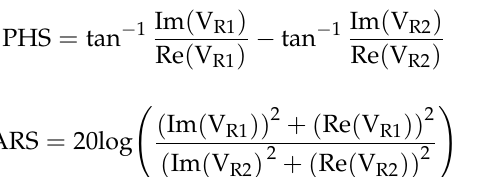
Figure 1. Relationship between induced voltage and formation resistivity under di ff erent source spacing: ( a ) Resistivity—real part of voltage correspondence; ( b ) Resistivity—image part of voltage correspondence.